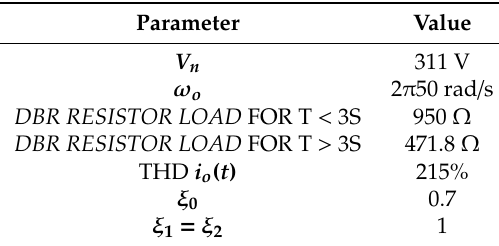
Figure 10. Simulation of the load current and P av transient responses for a linear load current perturbation from peak 2A to peak 4A at 3 s: ( a ) detail of the load current perturbation, ( b ) comparison between P av obtained with Figure 9 scheme ( P adv ) and P av obtained with Figure 5 scheme ( P droop ). Table 2. Simulation parameters for Figure